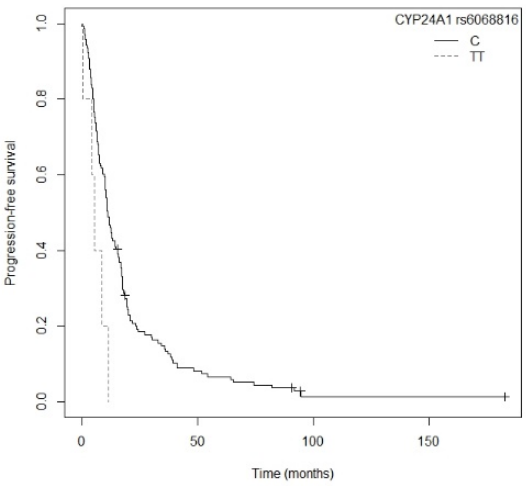
Figure 9. Kaplan–Meier plot of progression-free survival curves with the C allele of the CYP24A1 rs6068816 gene polymorphism in the non-resected NSCLC subgroup.